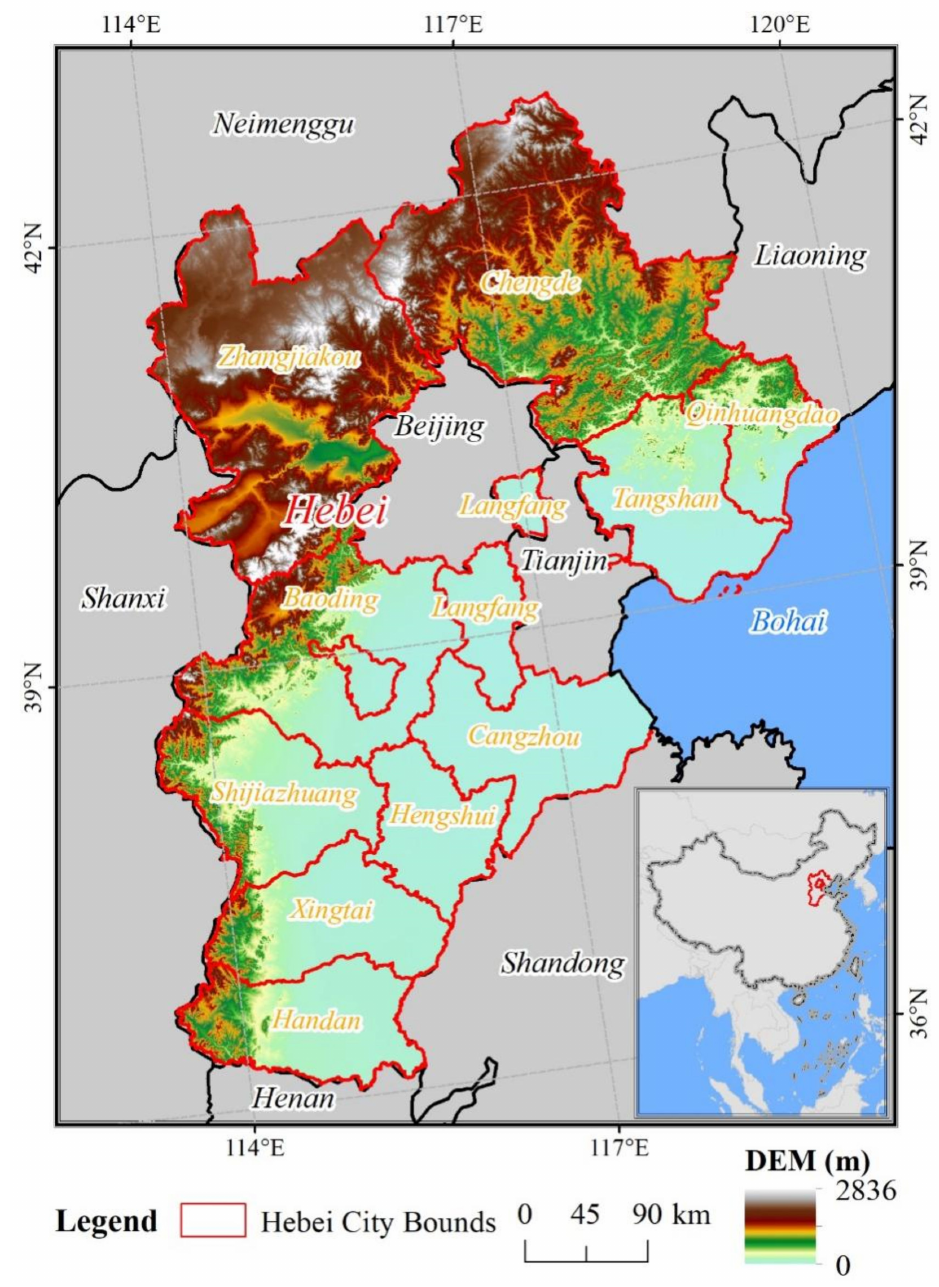
Figure 1. The geographical location and administrative division of Hebei